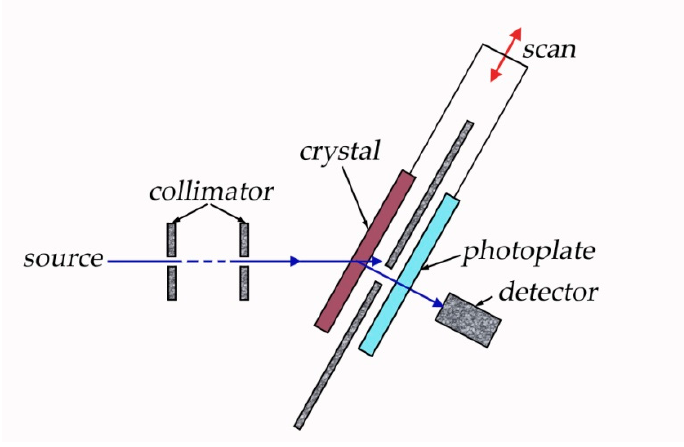
Figure 2. Scheme for obtaining topograms using the Lang